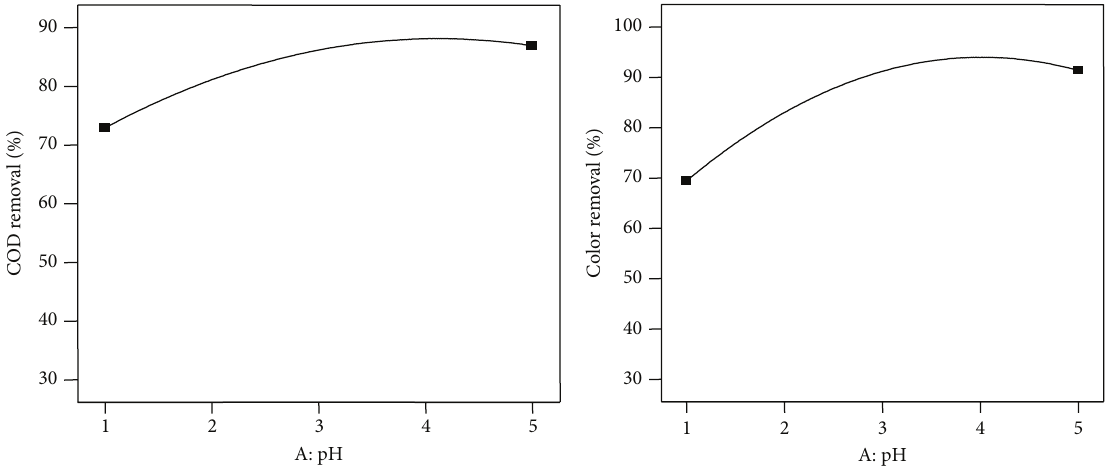
Figure 2: Effect of pH on COD and color removal.